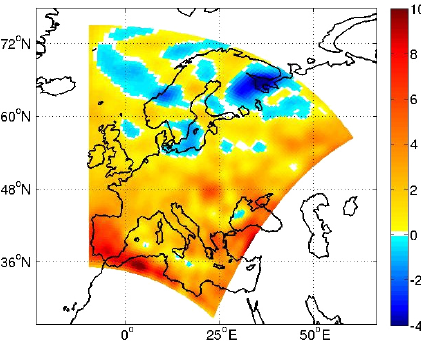
Figure 16. Difference in the annual mean CLWP for the (PD–PI) simulation expressed as a percentage.